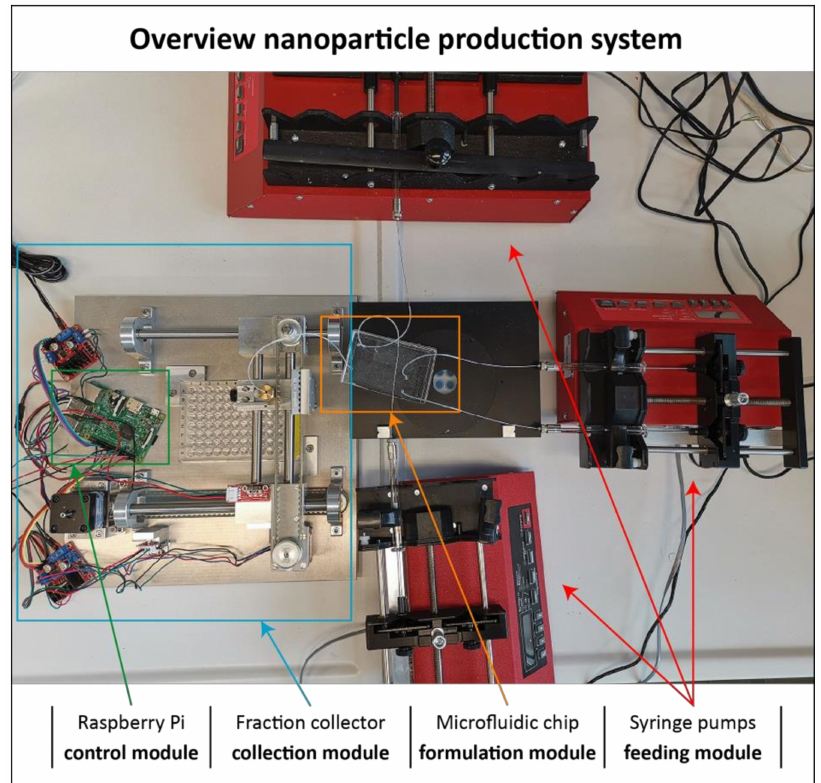
Figure 2. Overview over the nanoparticle production system. The system consists of four modules that can be used independently. The control module (green) is a raspberry pi which controls the collection module (blue), a custom-built fraction collector, via its GPIO pins. The raspberry pi controls the feeding module (red) via the RS232 interface. It is assembled from up to three syringe pumps. The formulation module can be any macro or microfluidic